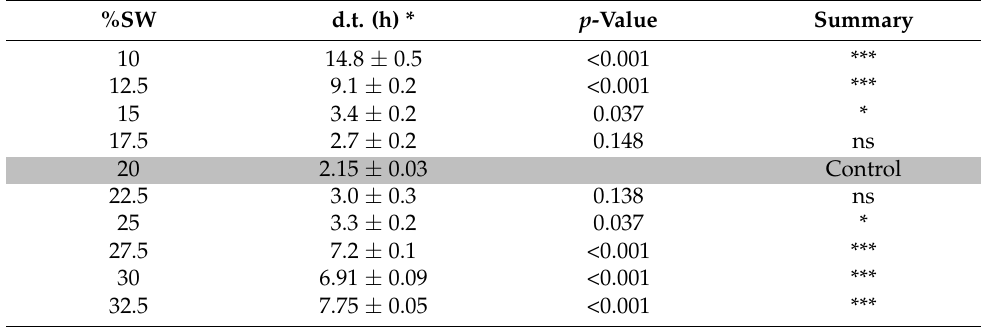
Table 1. Doubling time for Hfx. mediterranei under salinity stress